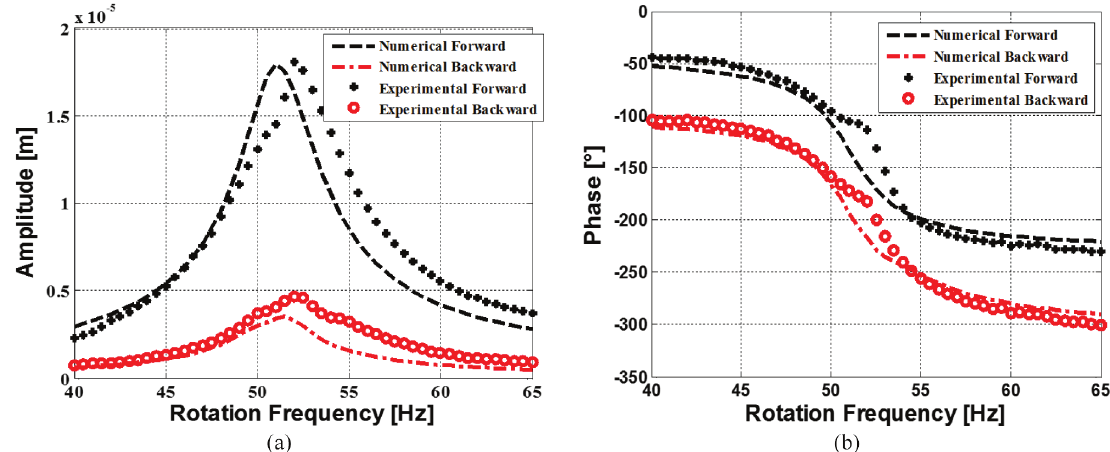
Figure 18 - Directional response of the system (bearing B2 position) for Case 3 – a) Amplitude and b)